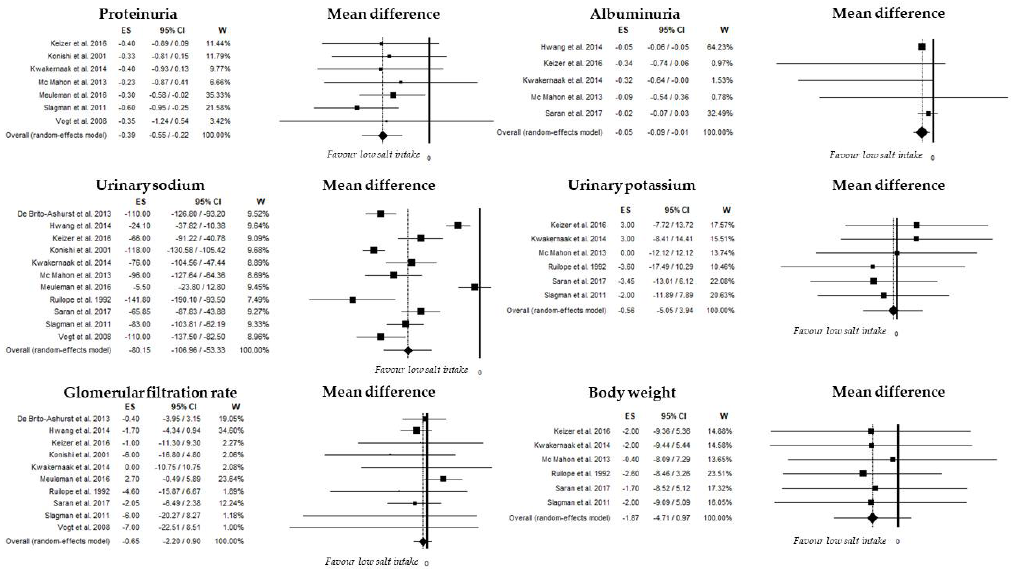
Figure 3. Mean difference of proteinuria, albuminuria, glomerular filtration rate, urinary sodium, urinary potassium and body weight in low- and high-salt intake.